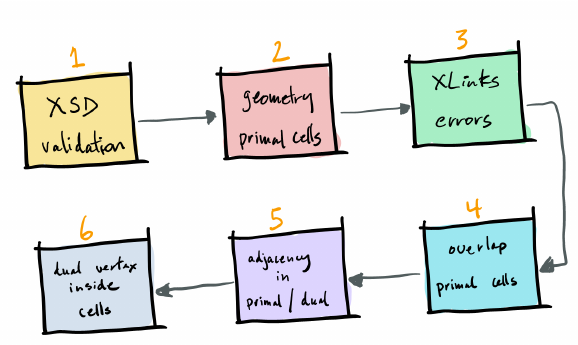
Figure 3. The six steps of the proposed